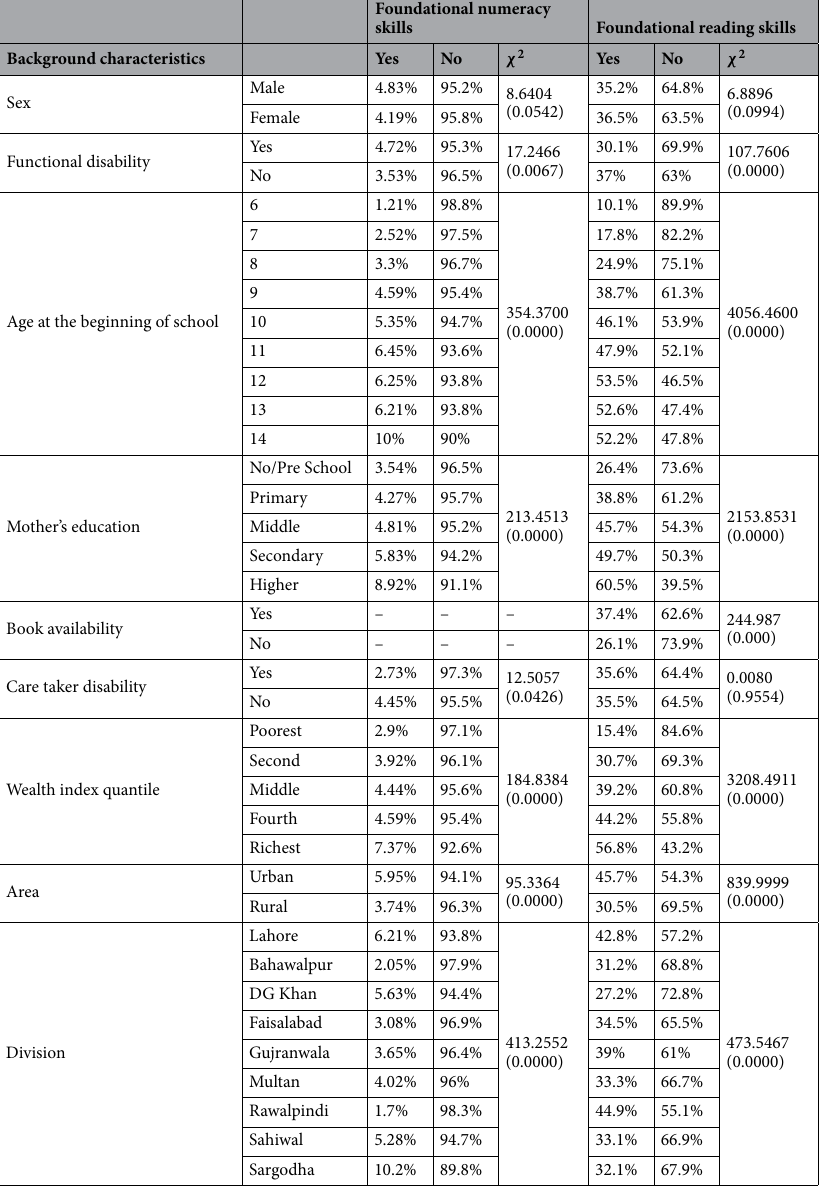
Table 1. Percentage Distribution of Children (Learning Skills × Background Characteristics) in MICS 2018, Punjab. p -value < 0.05 (significant), ( ) = p